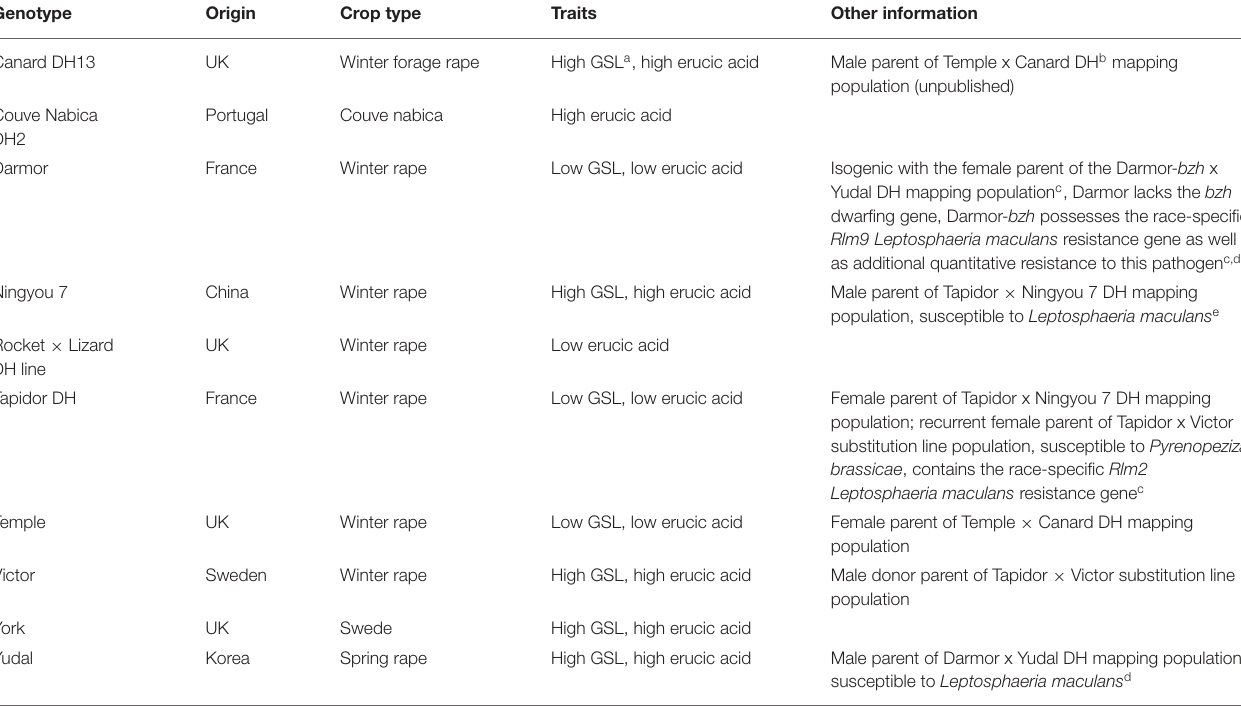
TABLE 1 | Origin and characteristics of oilseed rape genotypes used in the field experiment.